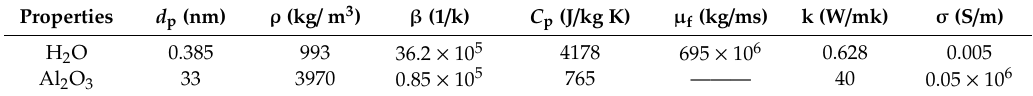
Table 2. Thermophysical Characteristics T = 310 K